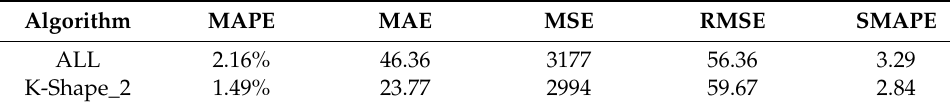
Table 1. Cluster ablation experimental results.